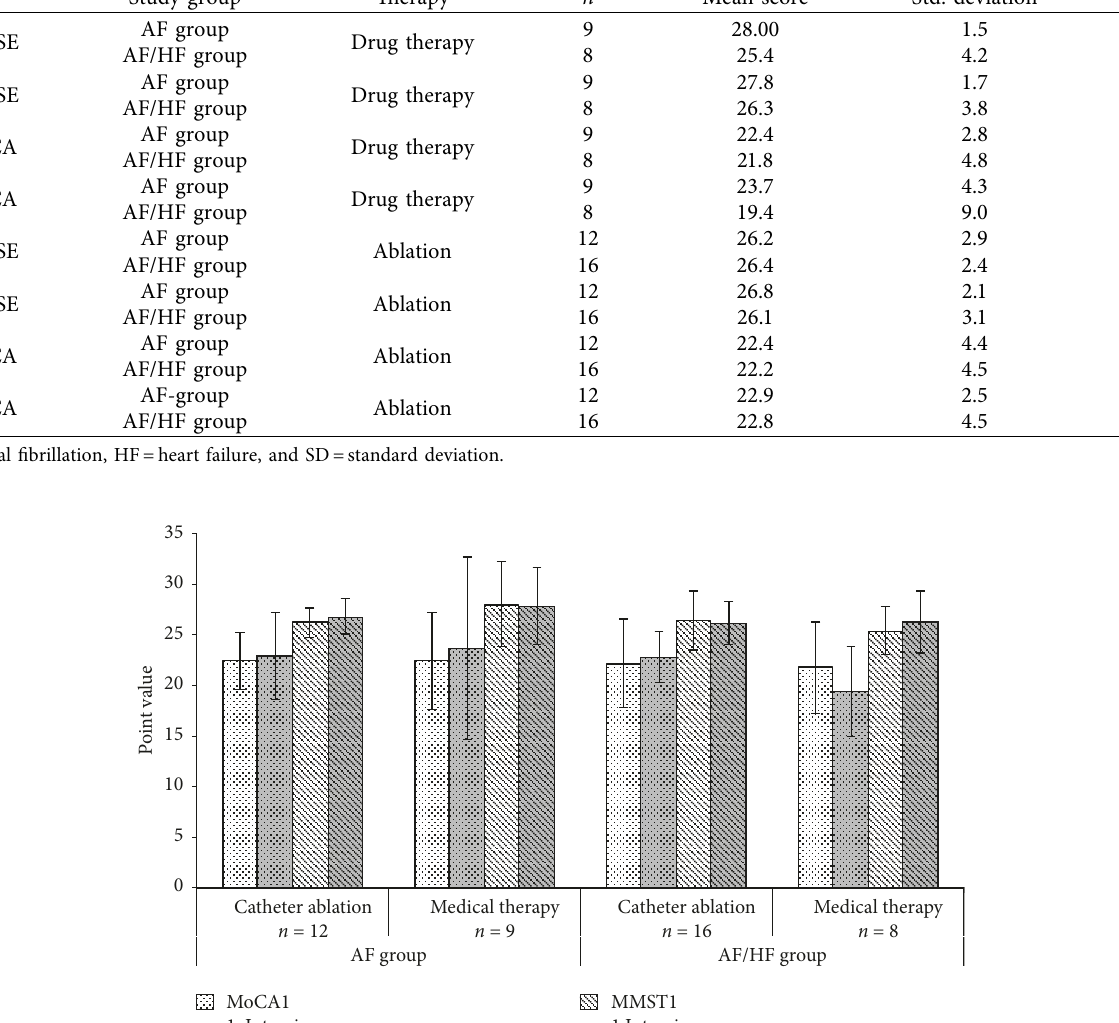
Table 3: Results of the AF and AF/HF group according to AF therapy in twice performed Mini-Mental State Examination (MMSE) and Montreal Cognitive Assessment tool (MoCA) with an intertest interval of 6 months.